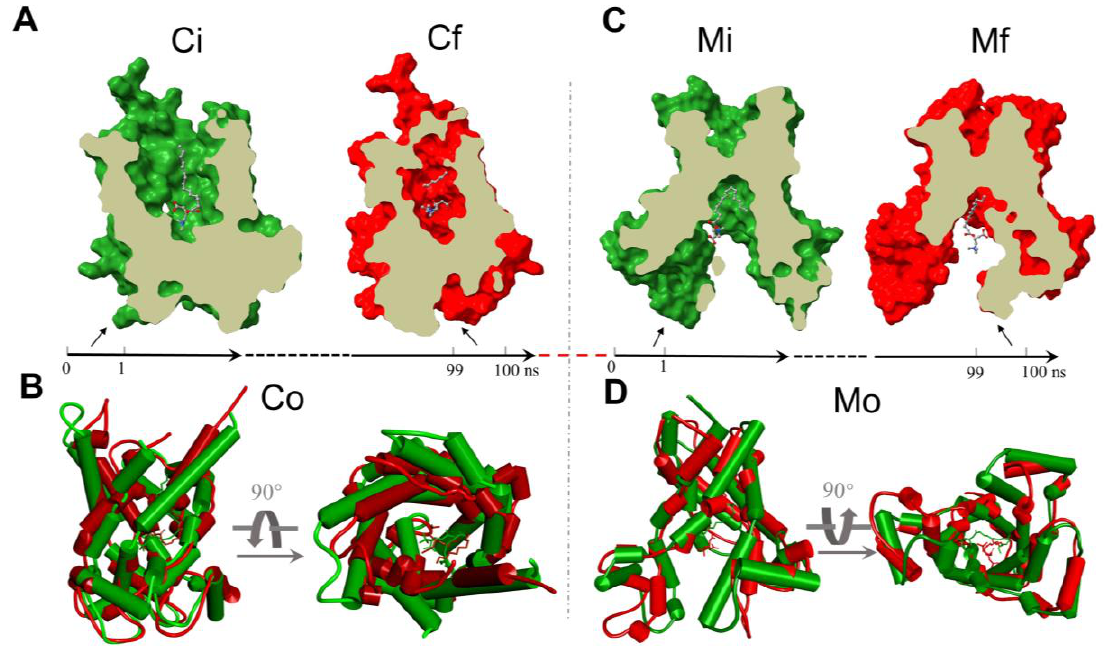
Figure 4. The average structures of the initial 1 ns (green) and final 1 ns (red) within 100 ns MD simulations for c-state open (C) and m-state open (M) CAC proteins, respectively. ( A ) Ci (initial) and Cf (final) indicate the downward translocation of the palmitoyl-L-carnitine within the c-state open CAC channel; ( B ) Co, the overlapped structures of c-state CAC (Ci and Cf), indicating an obvious trend of contraction for the mouth of c-state open; ( C ) Mi (initial) and Mf (final) indicate the motion of the palmitoyl-L-carnitine within the m-state open CAC channel; ( D ) Mo, the overlapped structures of m-state open CAC, indicating the dynamic status of m-state open CAC protein.